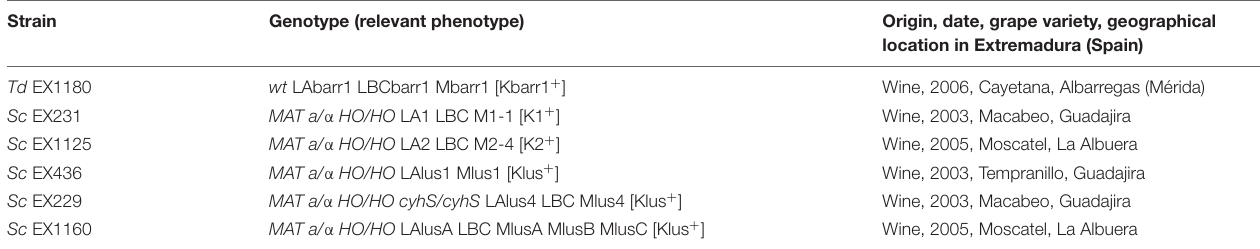
TABLE 1 | Yeasts used in this study. Strain Genotype (relevant